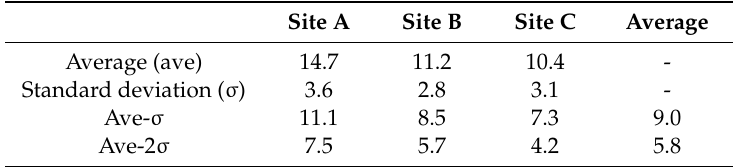
Table 1. The distribution of openness at ridgelines in Site A, Site B, and Site C